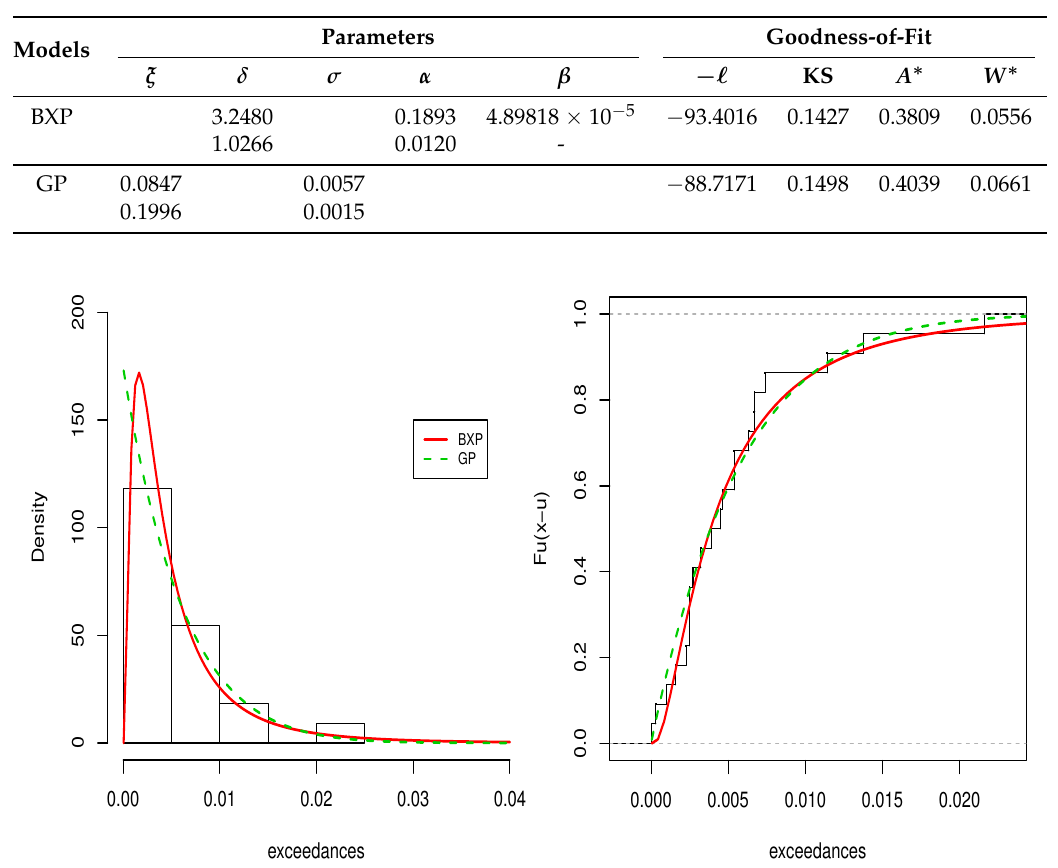
Table 6. MLEs, corresponding standard errors (in second line) and goodness-of-fit statistics for the S&P-500.